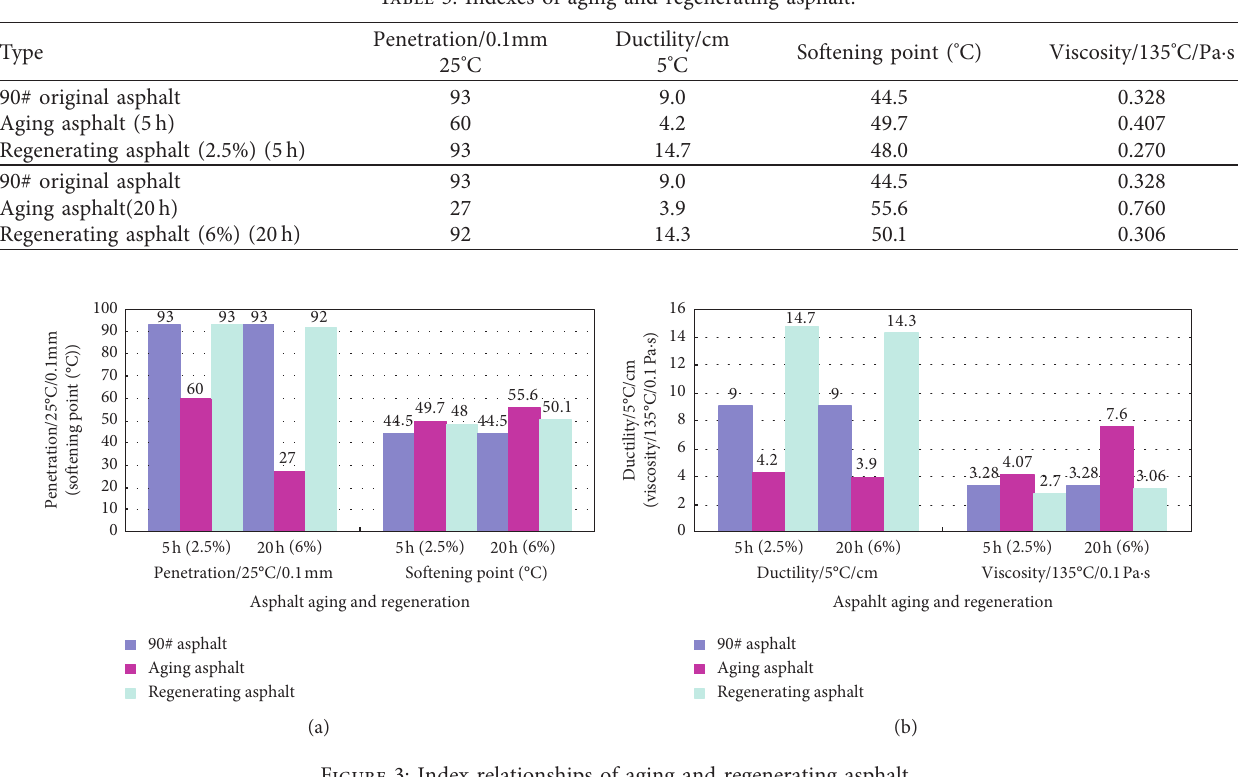
Table 5: Indexes of aging and regenerating asphalt.